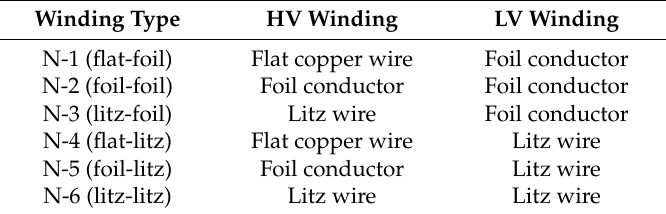
Table 2. Wire types of the six kinds of windings.